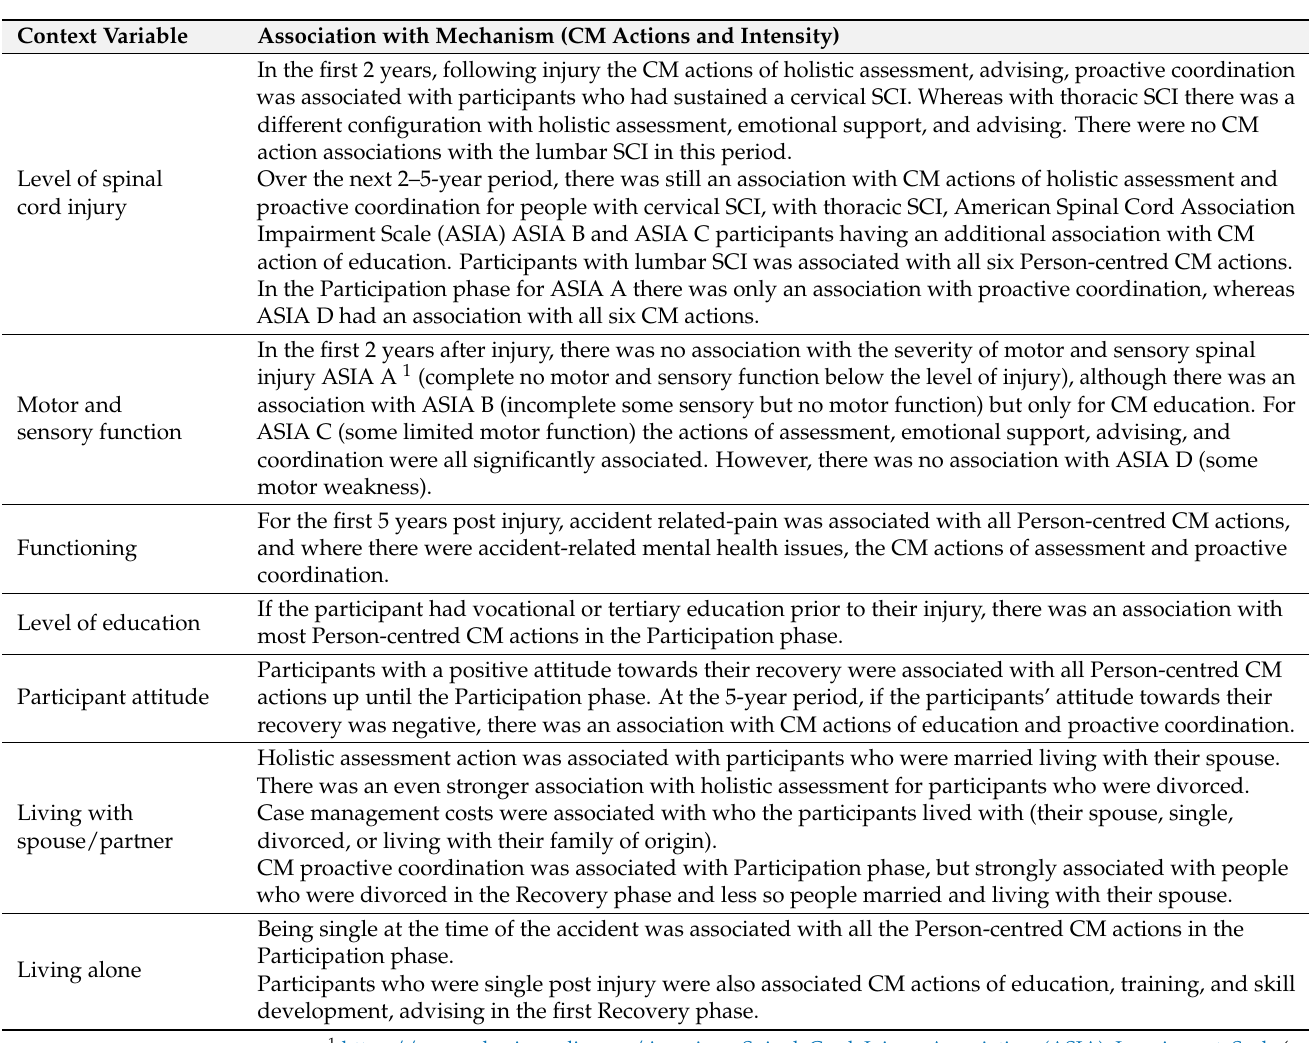
Table 6. SOMNet Results SCI cohort association of context with mechanism variables (weight- ing > 0.8